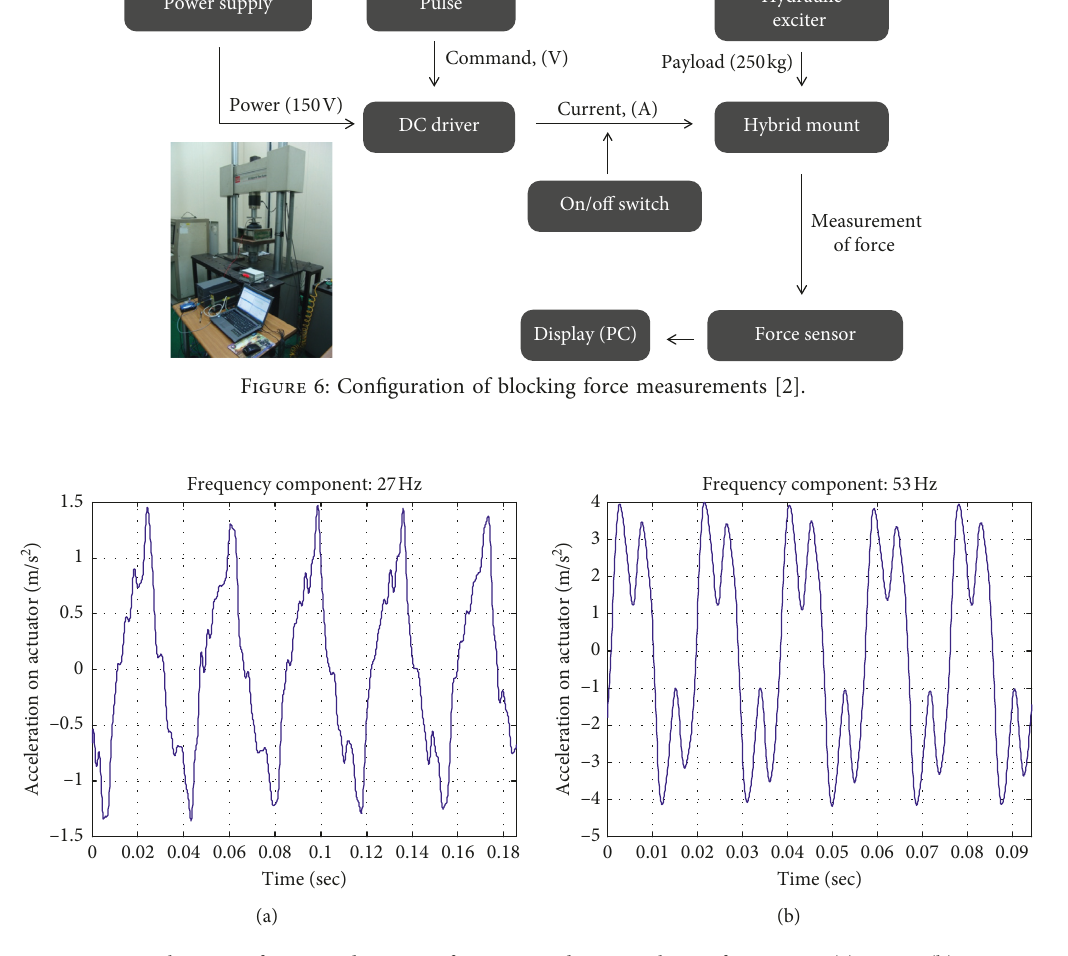
Figure 7: Acceleration of suggested actuator for command input voltage of pure sine. (a) 27Hz. (b) 53Hz. Table 4: Experiment condition for measurement of blocking